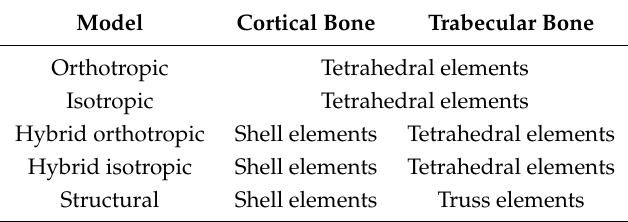
Table 1. Element type used to model cortical and trabecular bone for each model